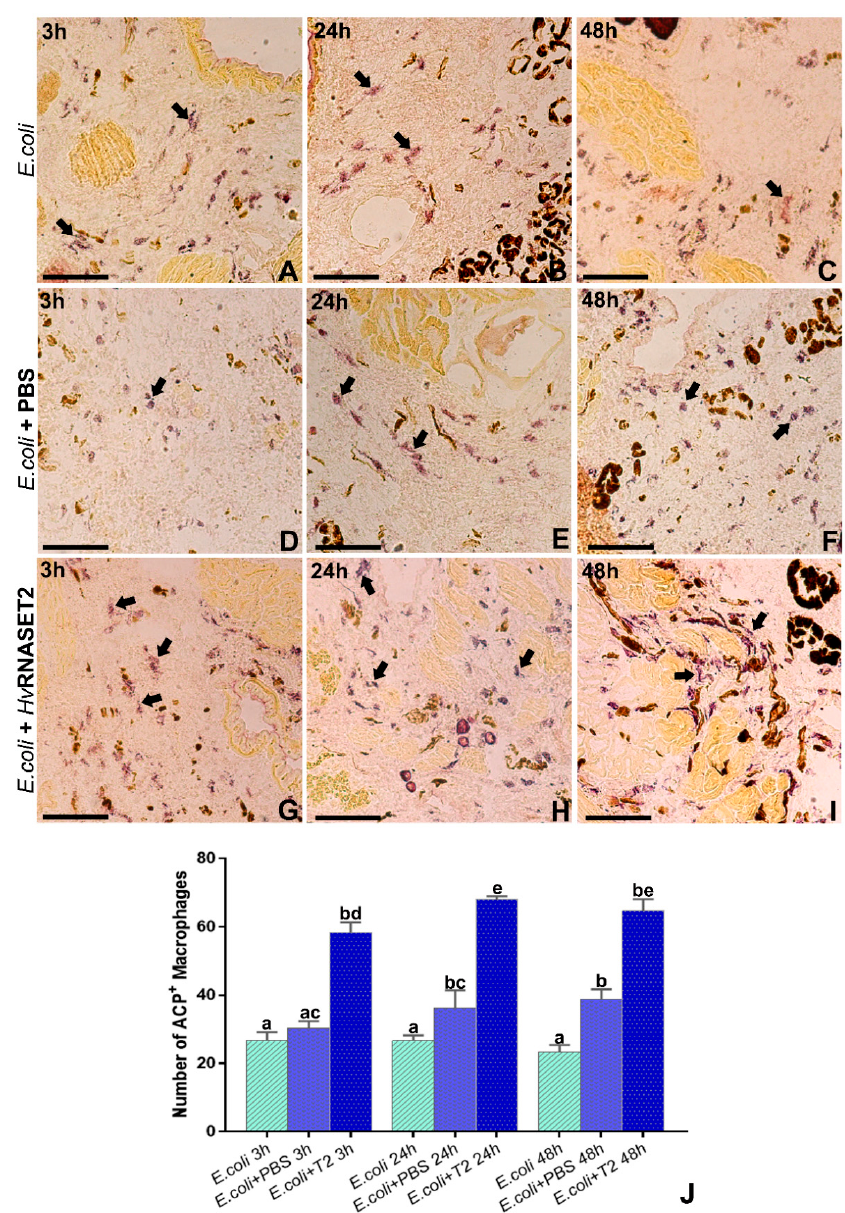
Figure 7. ACP assay. ( A – C ) E. coli alone injected in the leech body wall and tissues were analyzed after 3 h from treatment. Several ACP + -activated macrophages were detected in the challenged area. These cells are recognizable by the intense cytoplasmatic lysosomial activity (arrows). ( D – F ) E. coli were pre-incubated with PBS for 3 h, 24 h and 48 h and injected into the leech body wall. Tissues were analyzed 3 h after treatment, and the number of ACP + presented cells (arrows) was quite similar to those observed when bacteria are injected alone. ( G – I ) E. coli were pre-incubated with r Hv RNASET2 for 3 h, 24 h and 48 h and subsequently injected into the leech body wall. Tissues were analyzed after 3 h from treatment, and many ACP + macrophages are detected (arrows). ( J ) Graph showing the total positive ACP cells count. Means with di ff erent letters indicate a significant di ff erence between treatments at di ff erent times. Experiments were performed in triplicate, and data represent mean values ± SD. Statistical analyses were performed using Statistica 7.0 software, and di ff erences were calculated by one-way ANOVA followed by Tukey’s post hoc test. p < 0.05 was considered statistically significant. Scale bars: ( A – I ) 100 µ m. Di ff erent letters indicate statistically significant di ff erences ( p <